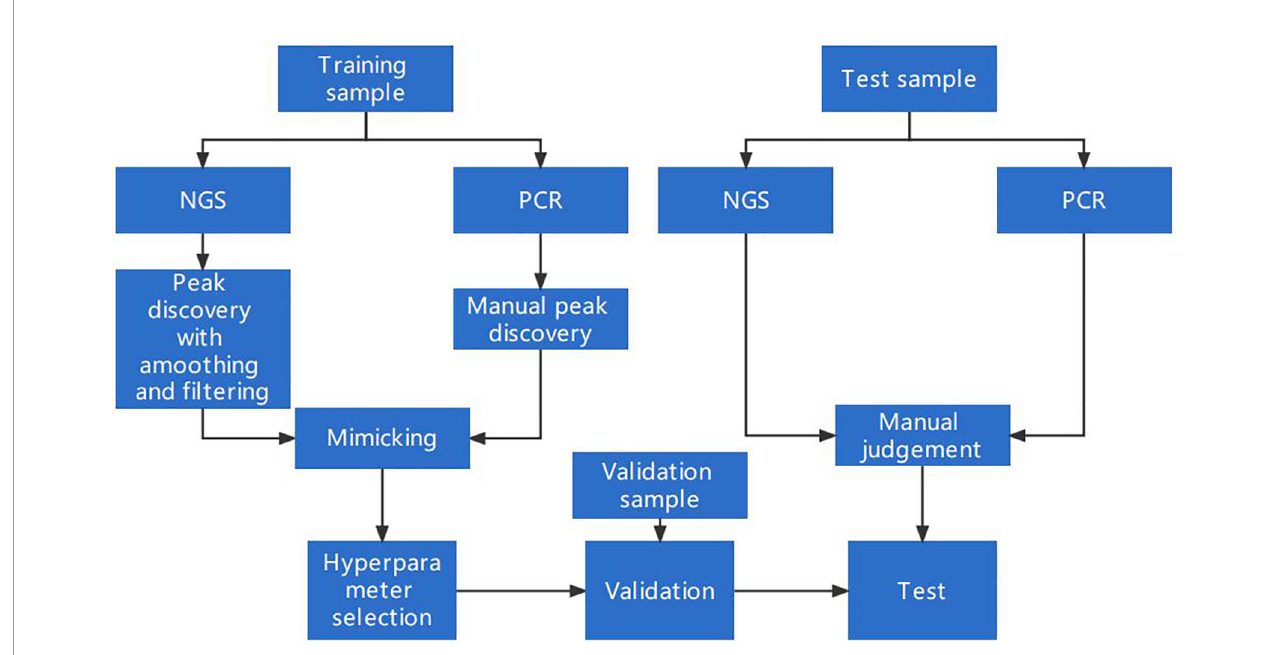
FIGURE 1 | A schematic for MSI detection and algorithm optimization. The dataset was split into three parts: a training set, a validation set, and a test set. The training set was used to design and optimize the peak- fi nding algorithm in the NGS data to mimic the PCR result. The validation set was used for determining whether the algorithm could be generalized to samples beyond the training set. The test set was collected independently to further evaluate the algorithm ’ s